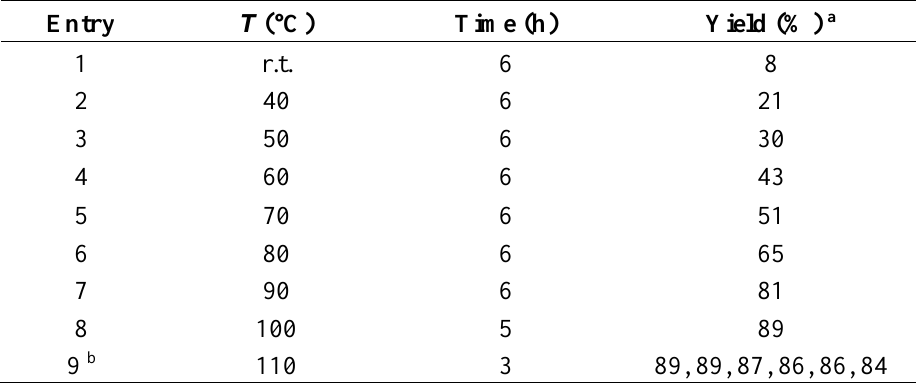
Table 1. Optimizing the reaction